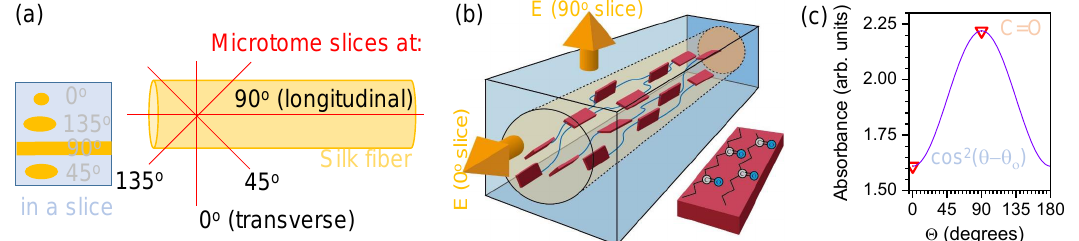
Figure 6. ( a ) Concept of four-angle absorbance measurements where instead of polarisation, four different orientation micro-tome slices are prepared. In this study we carried out measurements on two 90 ◦ and 0 ◦ longitudinal and transverse slices, respectively. ( b ) Visualisation of the a silk fiber with its internal β -sheet structure. ( c ) Orientation determination of C=O β -sheet absorbers at 1628 cm − 1 using different orientation slices (data markets for the transverse θ = 0 ◦ and longitudinal θ = 90 ◦ data) microtome slices; θ o is the initial orientation. Note, for quantitative determination of orientation, four orientation slices are